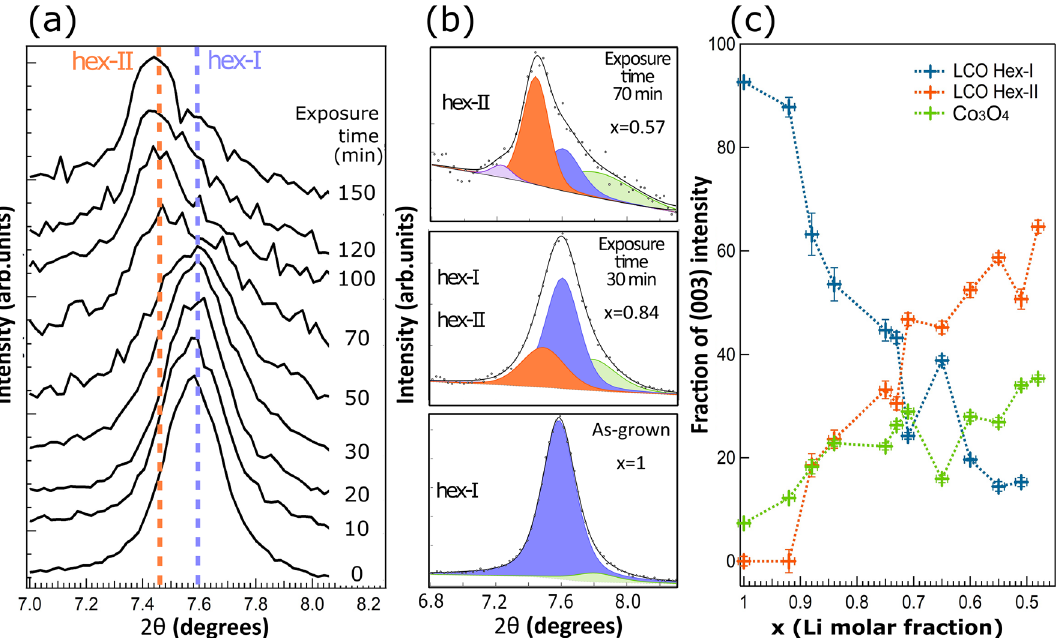
Figure 5. ( a ) Evolution of the (003) reflection in grazing incidence powder diffraction for increasing exposure times at 10 –2 M concentration. Note the splitting of the peak due to the coexistence of the hex-I and hex-II structures with different c lattice parameter and the shift of the maximum to lower angles as the exposure time increases. ( b ) Deconvolution of selected peaks corresponding to the (003) reflection including hex-I (blue), hex-II (orange), Co 3 O 4 (green), and residual strongly delithiated areas (magenta). (c) Intensity of the different components (hex-I, hex-II and Co 3 O 4 ) in the (003) reflection as a function of Li molar fraction. For each exposure time, the relative intensities of components are normalized with respect to the total intensity of the (003) reflection for that particular exposure time. Figure created with Igor Pro 6.3.7.2 (Wavemetrics, Lake Oswego, OR, USA, https:// www. wavem etrics. com) and Inkscape 1.0.2 (Copyright (C) 1989, 1991 Free Software Foundation, Inc. 51 Franklin Street, Fifth Floor, Boston, MA 02110-1301, USA, https:// inksc ape. org/